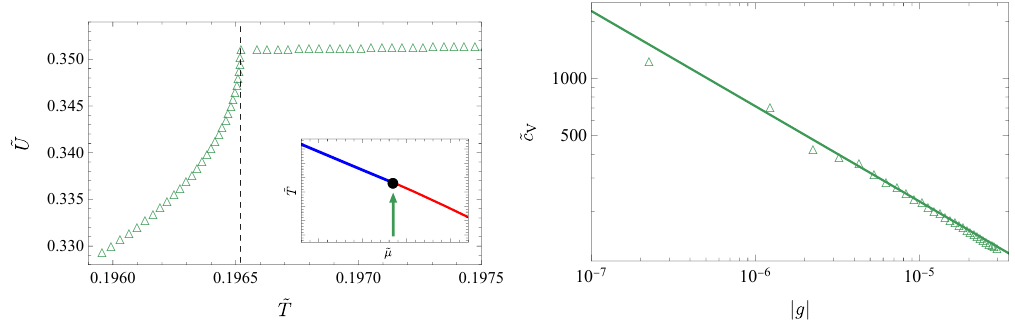
Figure 6 . The left panel shows the critical behavior of the internal energy as a function of tem- perature. The inset shows the phase diagram, and the arrow denotes the path with the chemical potential fixed. The vertical dashed line denotes the tricritical temperature. The right panel shows the critical behavior of the specific heat in log scale. The open triangles and solid line denote the numerical data and the fitting result,